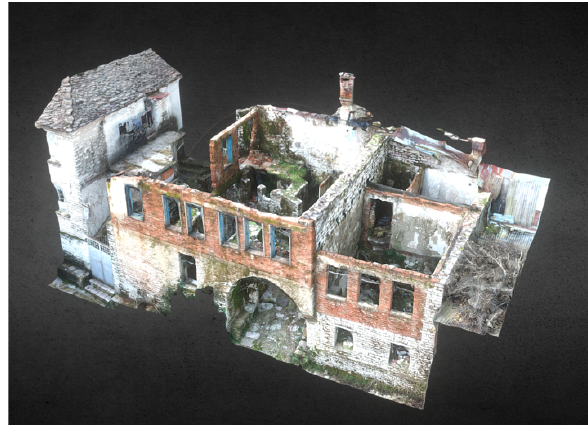
Figure 7. 3D model of Zekate house (© F.